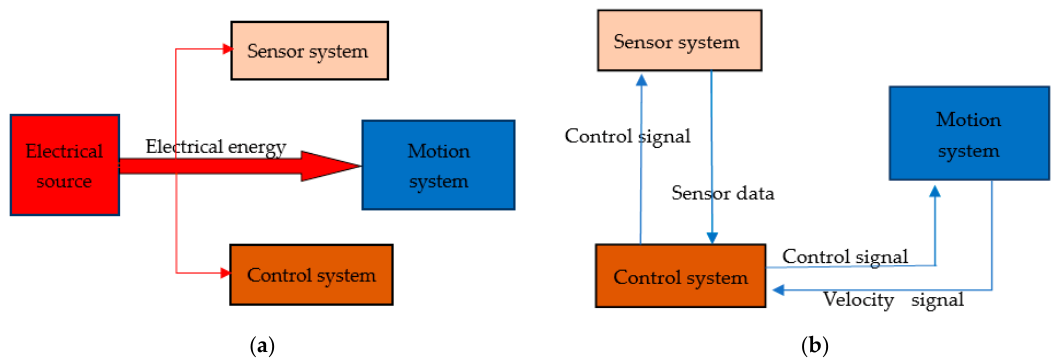
Figure 1. Block diagram of the system. ( a ) Electrical energy transmission; ( b ) Signal transmission.